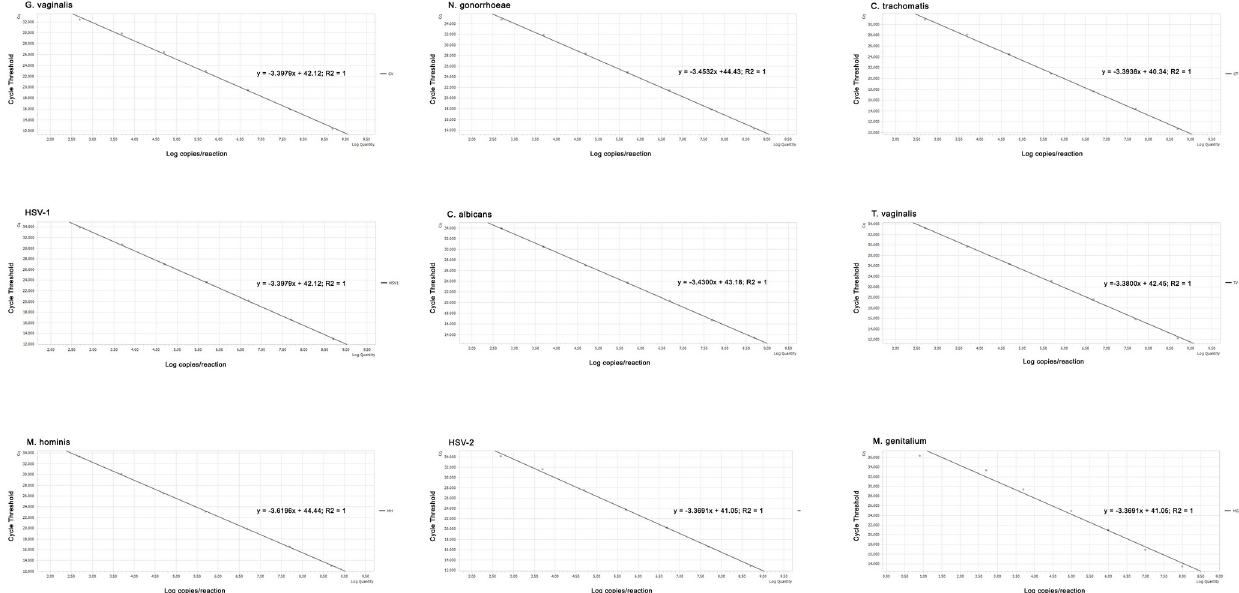
Fig 2. Standard curves representing for the relationship between log10 plasmid copies/reaction and the threshold cycle (C t ). Equations: y = -ax + b with R 2 for amplification of nine pathogens.